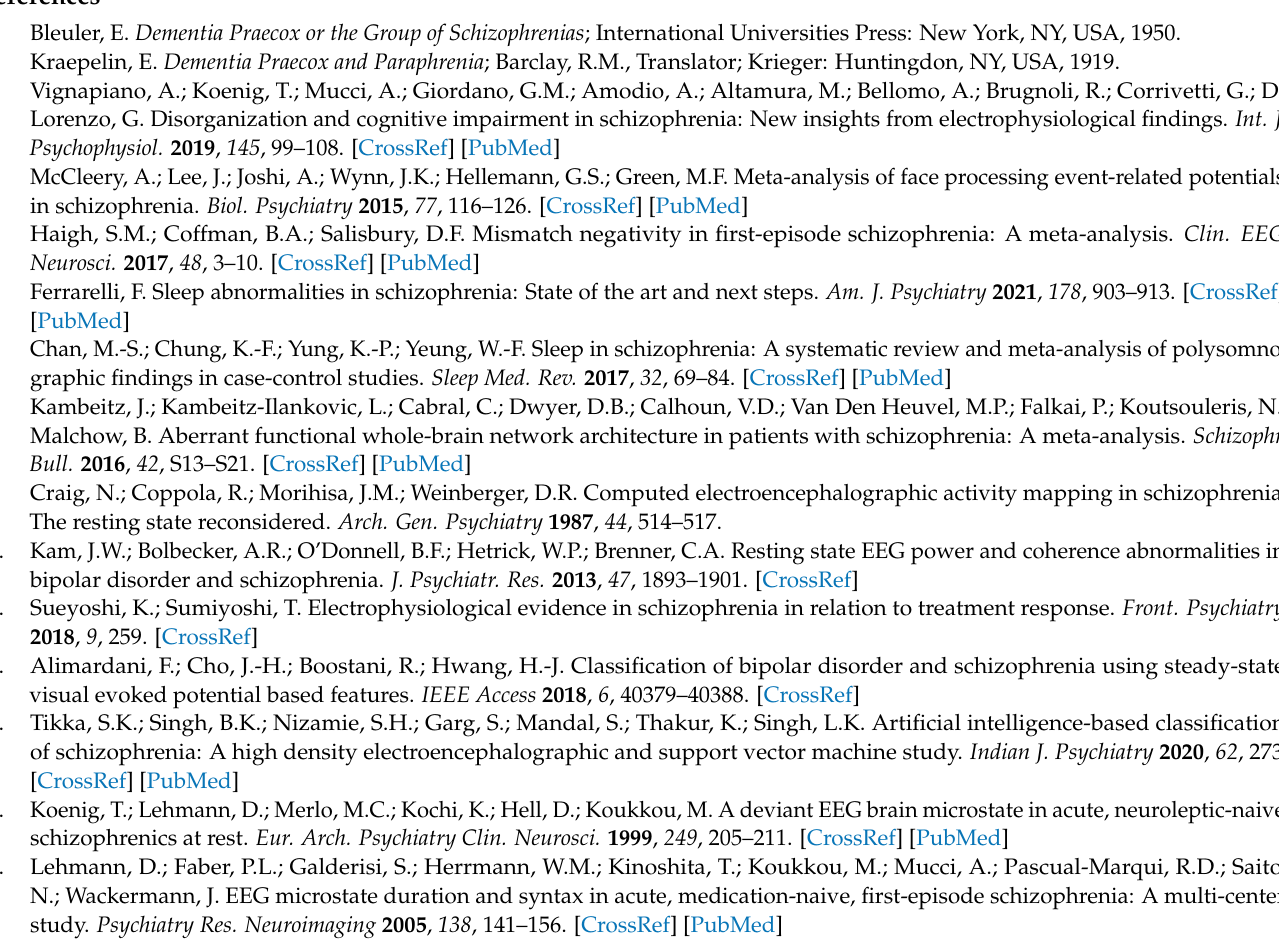
Figure S6: Subject-based histogram of SZ microstate features; Figure S7: Global explained variance (GEV) rate for choosing different numbers of archetypes